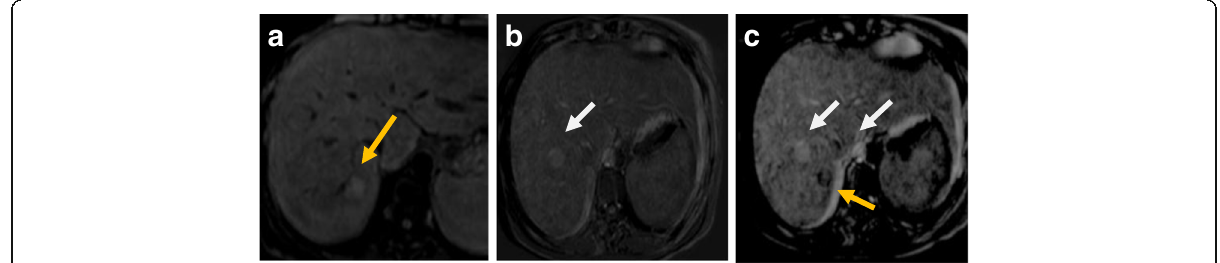
Fig. 2 MRI after RF. a Pre-contrast T1-WI fat-suppressed image shows the ablated HFL at subsegment VII (yellow arrow) with its bright signal due to coagulative necrosis. b Subtracted arterial phase at a higher level shows slice mis-registration between the pre-contrast and post-contrast image and mirror image of the aorta (white arrow). c Subtracted arterial phase at the HFL shows slice mis-registration between the pre-contrast and post-contrast image and mirror image of the aorta (white arrow) with eccentric faint enhancement at the lesion (not consistent with the residual viable tumor). Final diagnosis is LR-TR nonevaluable due to image